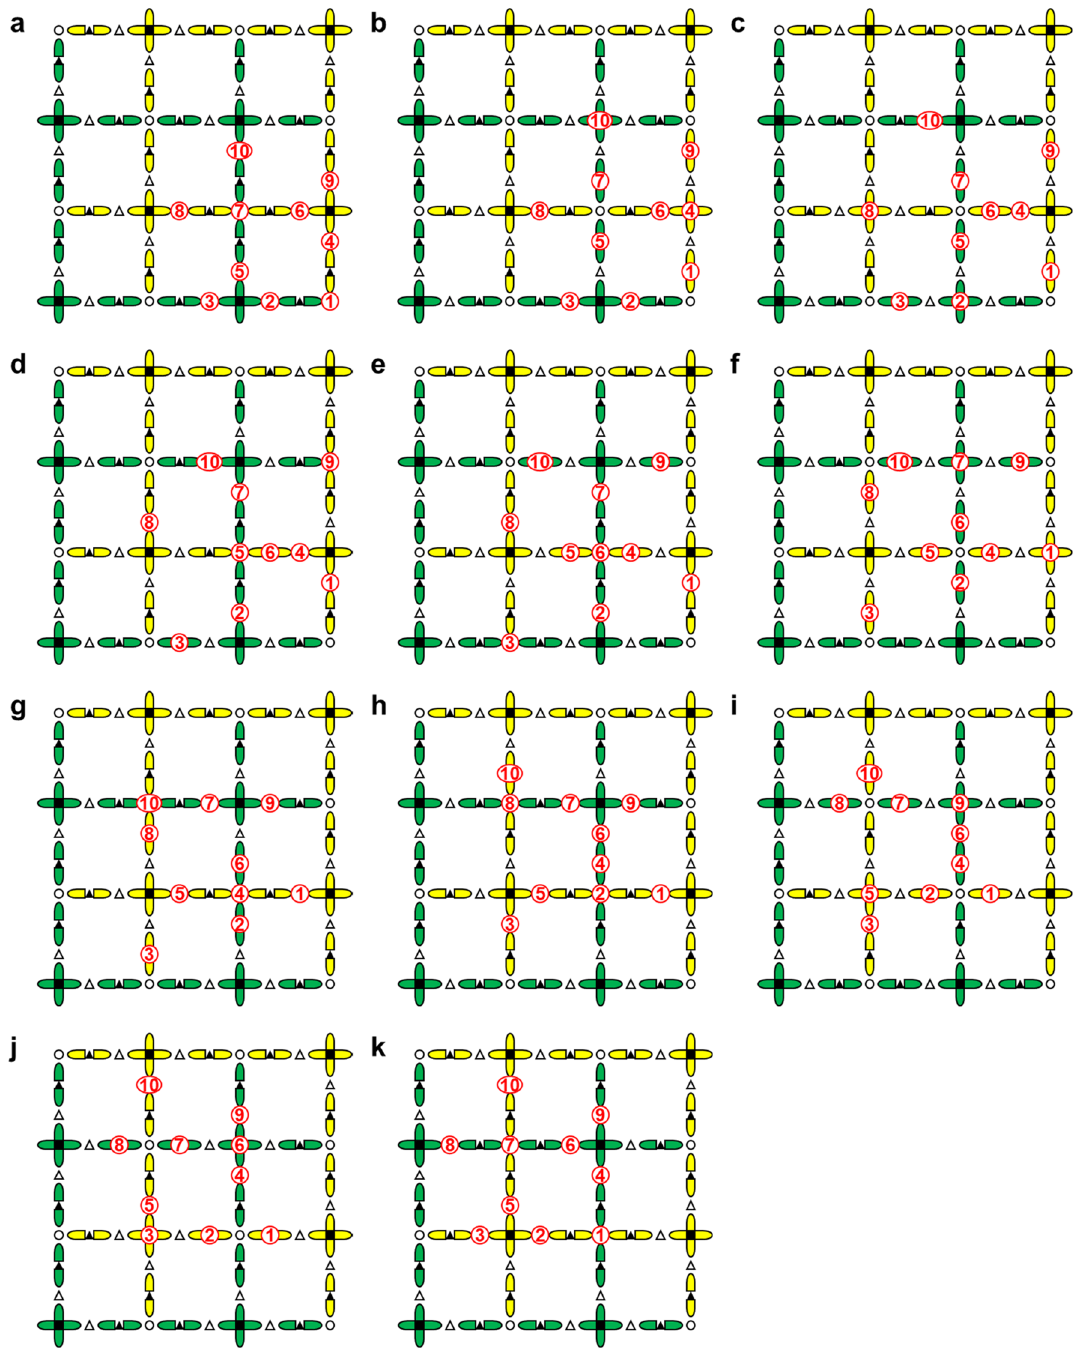
ˆ H Figure 6. Procedure for the parallel displacement included in L . ① – ⑩ depict data qubits in a primitive cell. ( a ) Initial state. ( b , d , f , h , j ) Physical qubits on vertical edges and on nodes of the grid are vertically displaced by one step. The displacement is achieved using swap gates in units of row. ( c , e , g , i , k ) Physical qubits on horizontal edges and on nodes of the grid are horizontally displaced by one step. The displacement is achieved using swap gates in units of column. ( k ) As a result of the displacements, the data qubits are displaced from the initial state by half the primitive cell. There are intervals during these swap processes when error detection measurements cannot be performed. In ( f ), the positions of the syndrome qubits and the data qubits are temporarily